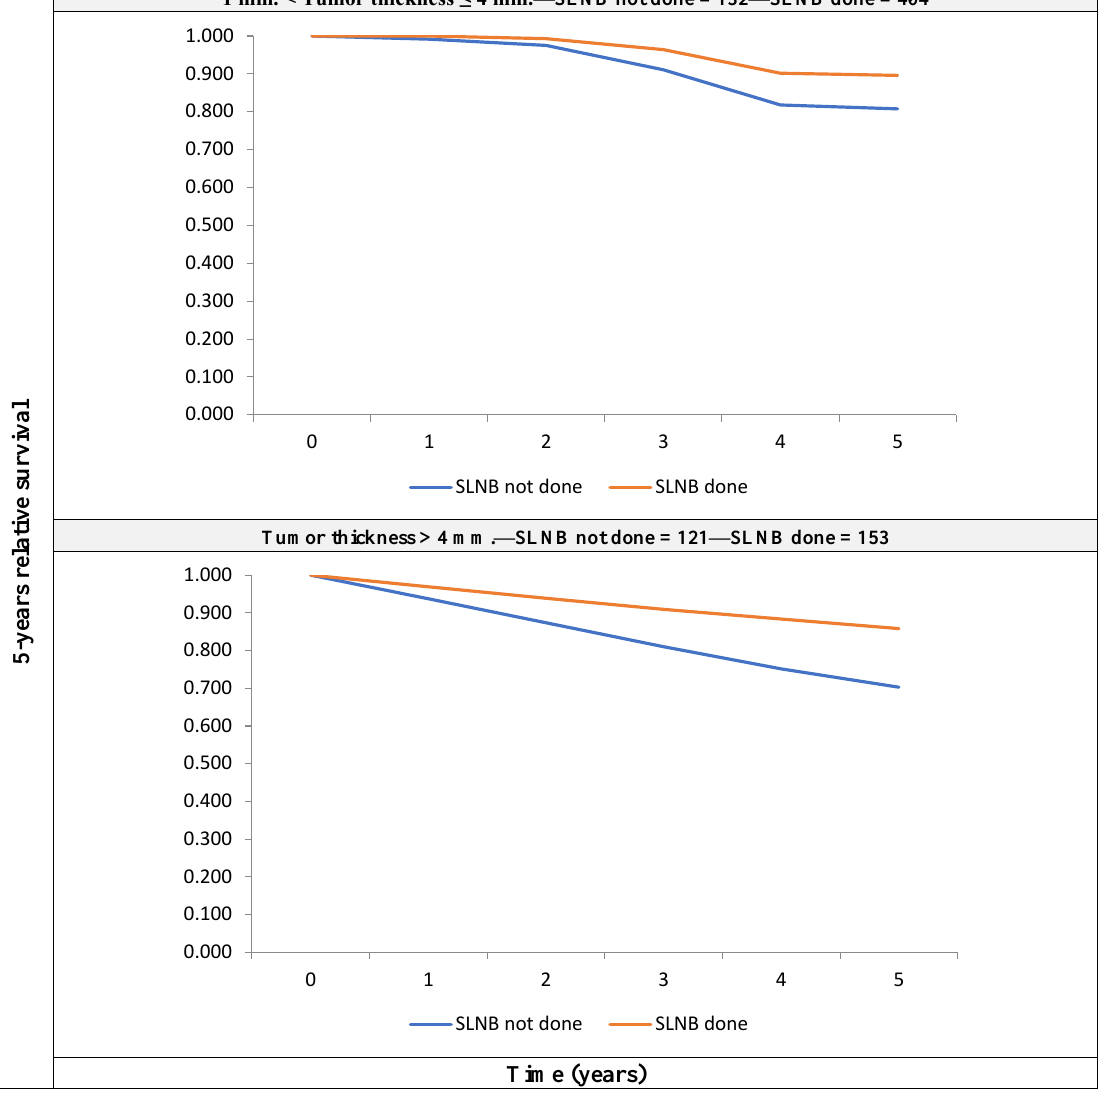
Figure 2. 5-year crude relative survival by tumor thickness, for patients with non-metastatic clinically node-negative (cN0M0) melanoma with thickness >1 mm, for those who underwent SLNB and those who did not receive it.